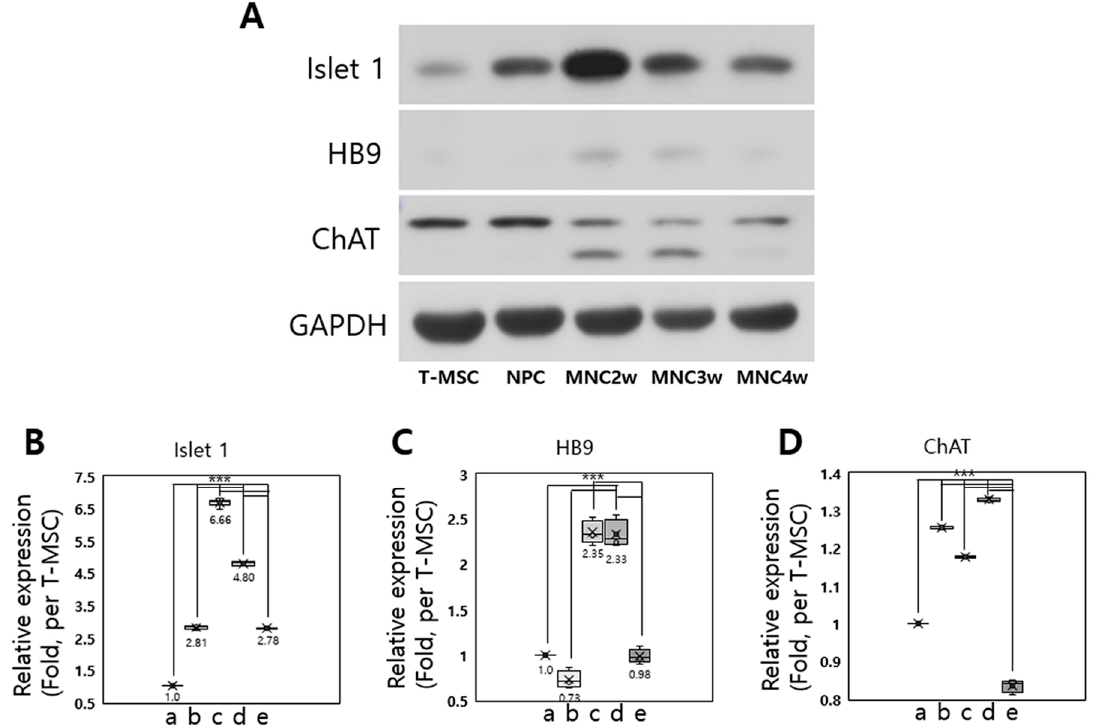
Figure 3. Detection of MN markers during di ff erentiation into MN-like cells. ( A ) Western blot analysis of the expression of the Islet 1, HB9, and ChAT proteins during di ff erentiation of T-MSC-MNCs from T-MSC ( n = 3). The expression of the Islet 1 ( B ), HB9 ( C ), and ChAT ( D ) proteins was quantified by densitometry using ImageJ software. Protein expression levels are normalized to GAPDH. Data are presented as the mean ± SEM of at least three experiments. T-MSC (a); NPC (b) = neural precursor cell; MNC2w (c) = 2 weeks of di ff erentiation; MNC3w (d) = 3 weeks of di ff erentiation; and MNC4w (e) = 4 weeks of di ff erentiation. The statistical analysis was performed using one-way ANOVA (*** p <